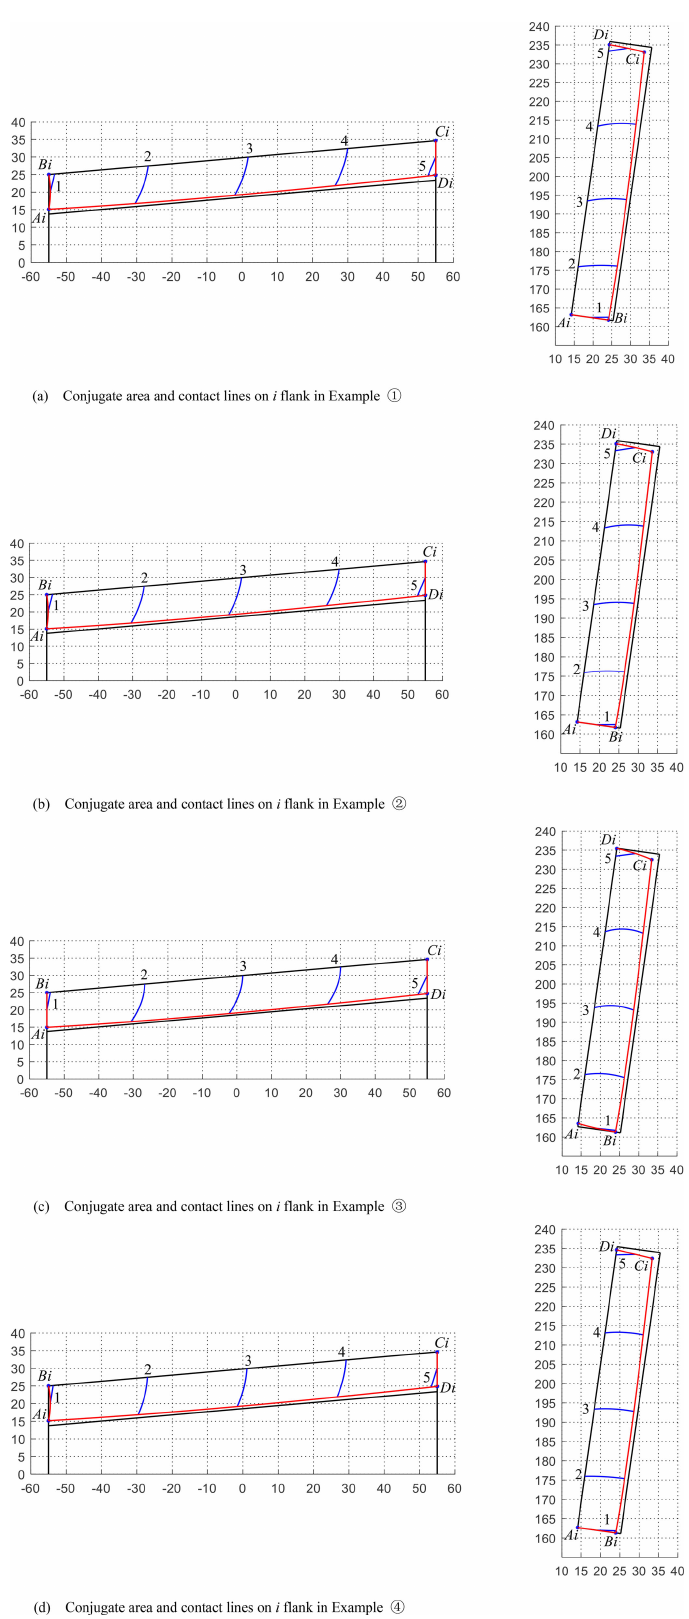
Figure 6. Global meshing performance of the i flank in the